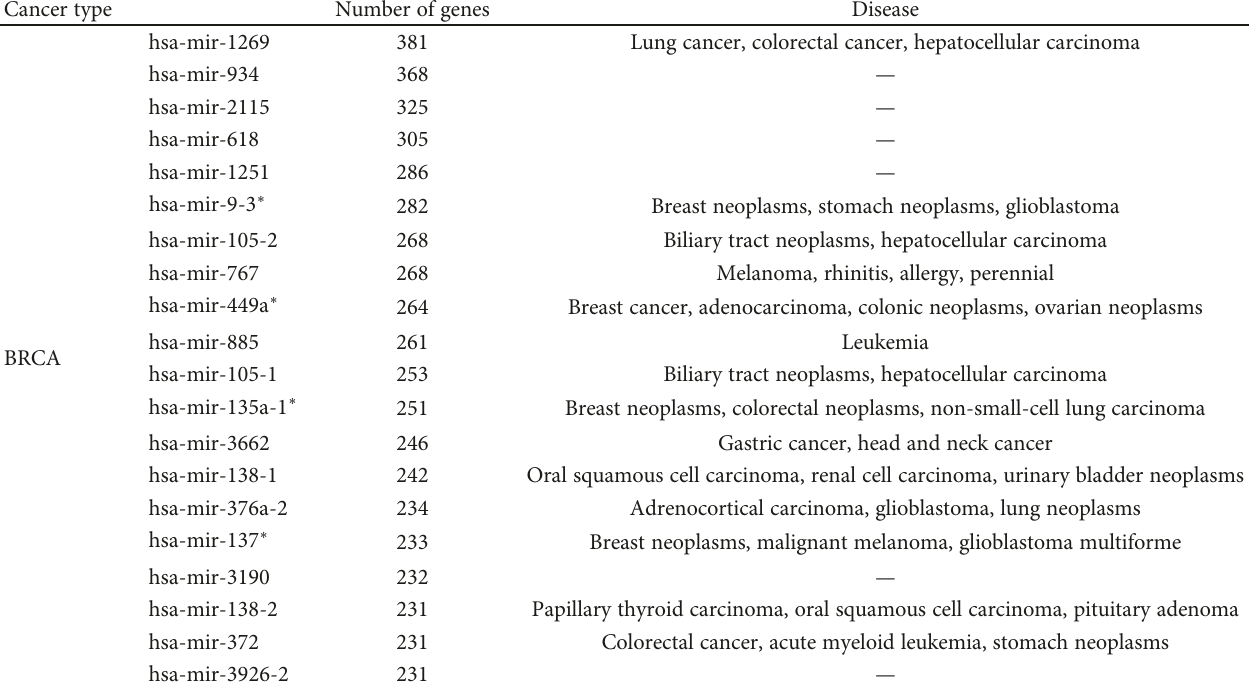
Table 2: The annotation of the top 20 miRNAs in